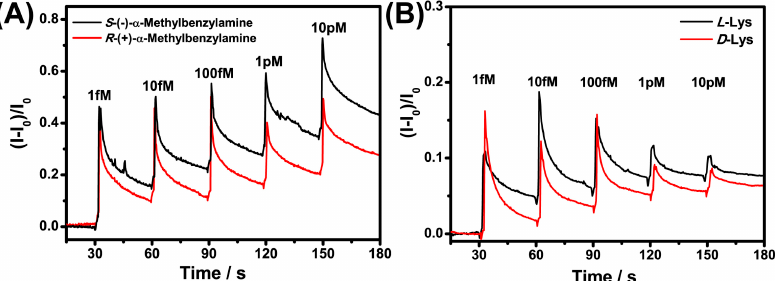
Figure 7. Chiral recognition of positively charged α -Met ( A ) and Lysine ( B ) enantiomers by Nafion– GO@BSA-EG-MOSFET.